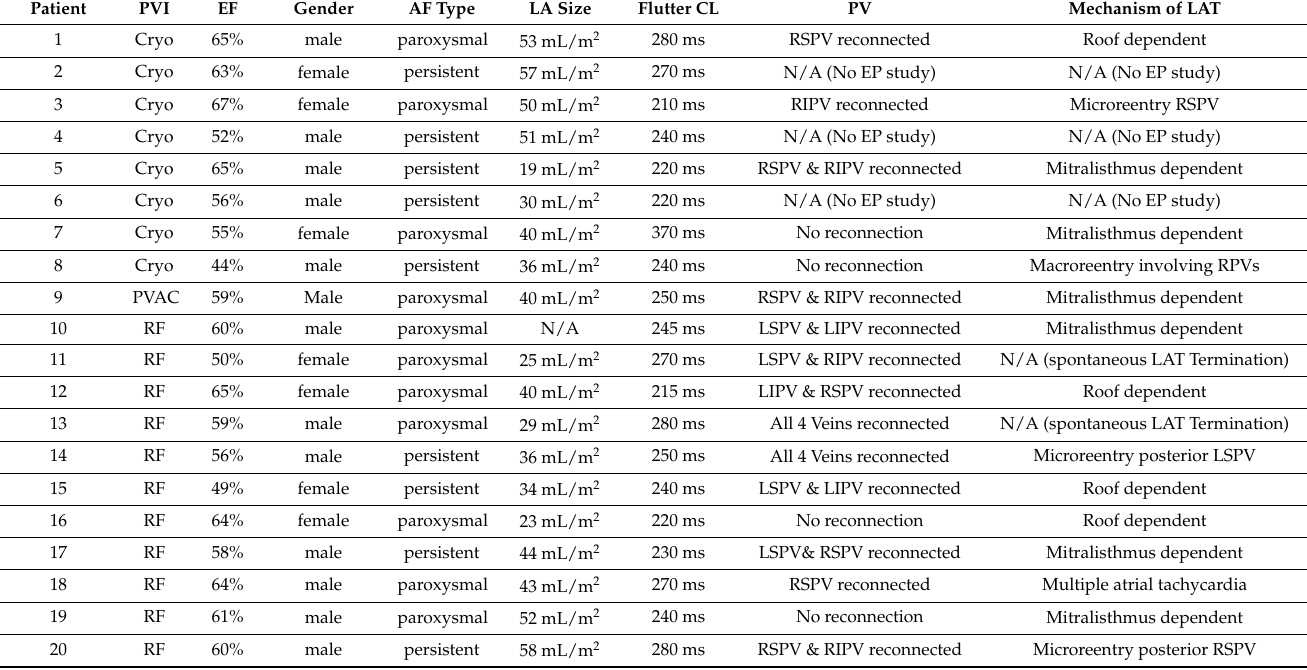
Table 2. Patient characteristics of the LAT patients and mechanisms of LAT (EF: ejection fraction; AF: atrial fibrillation; LA: left atrial; CL: cycle length; LSPV: left superior pulmonary vein; LIPV: left inferior pulmonary vein; RIPV: right inferior pulmonary vein; RSPV: right superior pulmonary vein; RPV: right pulmonary veins; EP study: electrophysiological study).